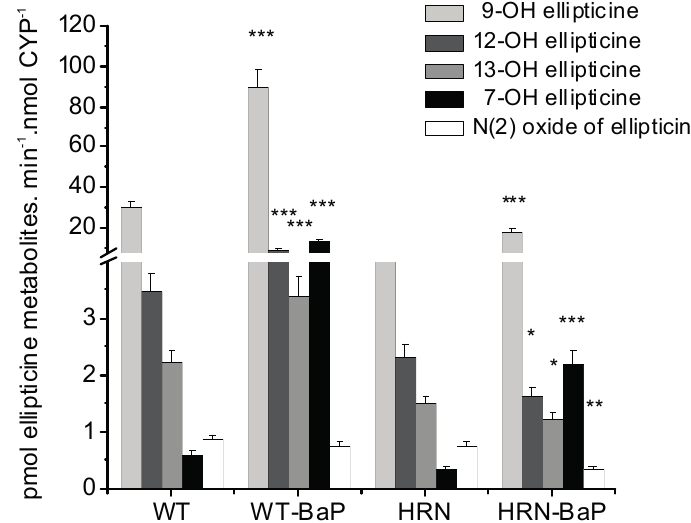
Figure 7. Levels of ellipticine metabolites formed by hepatic microsomes (0.2 mg protein) of Hepatic Cytochrome P450 Reductase Null (HRN) and wild-type (WT) mice from 10 μ M ellipticine and by hepatic microsomes of HRN and WT mice pre-treated with BaP.